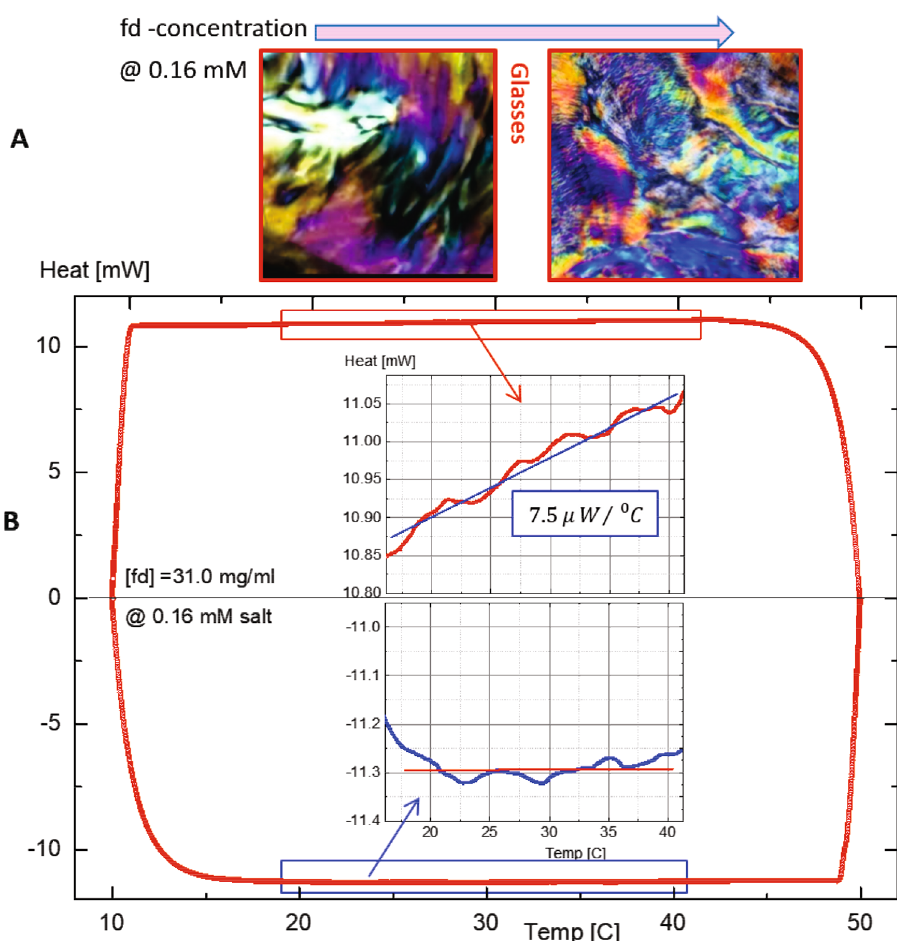
Figure 9. ( A ) Different optical contrasts of the glass state at a low ionic strength of 0.16 mM, where more colorful birefringence is evident as the concentration increases. ( B ) Athermal specific heats of glass state are measured by the heat flow of a high concentration for the glass concentration (of 31 mg/ml) at a low ionic strength of 0.16 mM salt by differential scanning calorimetry (DSC). The insets show the specific heats with the different response for the heating (top) versus the cooling (bottom) process respectively. The constant value of specific heat during cooling may explain the steadiness of the thermal stability, for both the glass states and the chiral-nematic orientation textures in the equilibrium